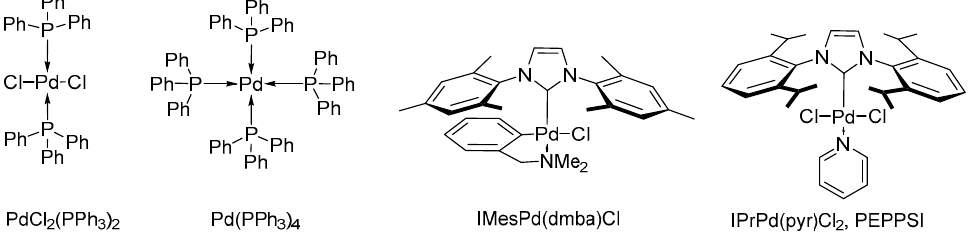
Figure 1. Pd-complexes used as catalyst in the studied reaction.